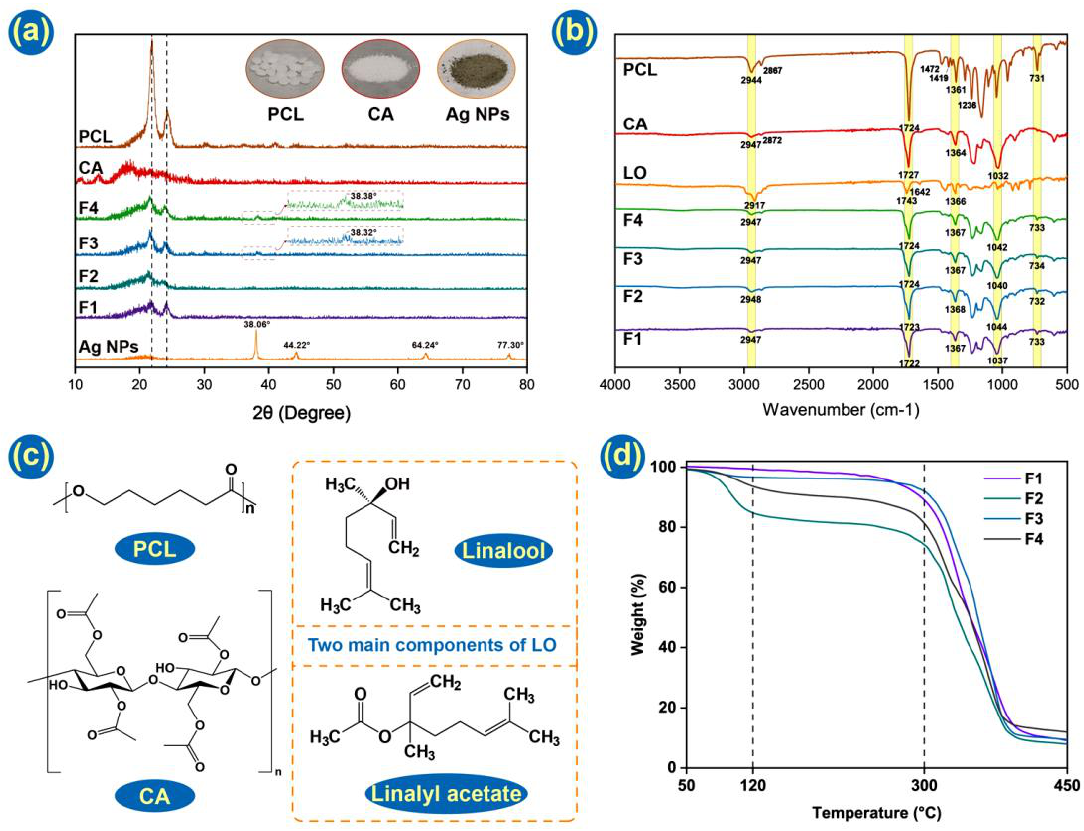
Figure 6. ( a ) XRD patterns of the raw materials and fibers. Inset: photographs of the raw materials; ( b ) FTIR results of raw materials and nanofibers; ( c ) Structural formula of PCL, CA and two main components of LO; ( d ) TGA diagram of four prepared fiber membranes.